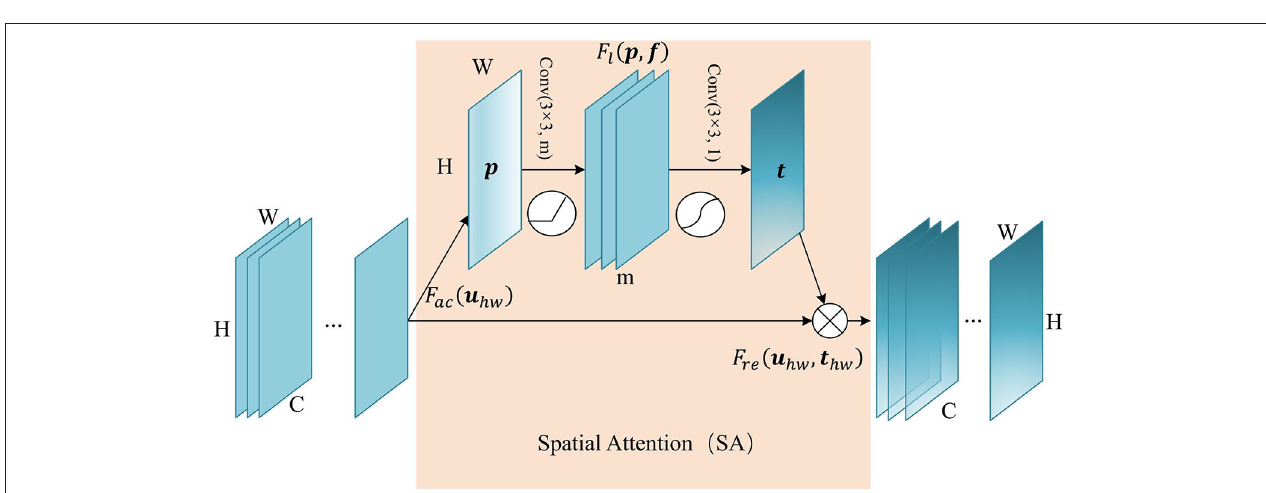
aims to fully capture the dependencies between channels and where w 1 ∈ R K × C , w 2 ∈ R C × K . K refers to number of hidden neurons. σ is a sigmoid activation function used to generate channel weights v c ∈ (0, 1), at channel c . With fully- connected hidden layers, it can capture the non-linear interaction between